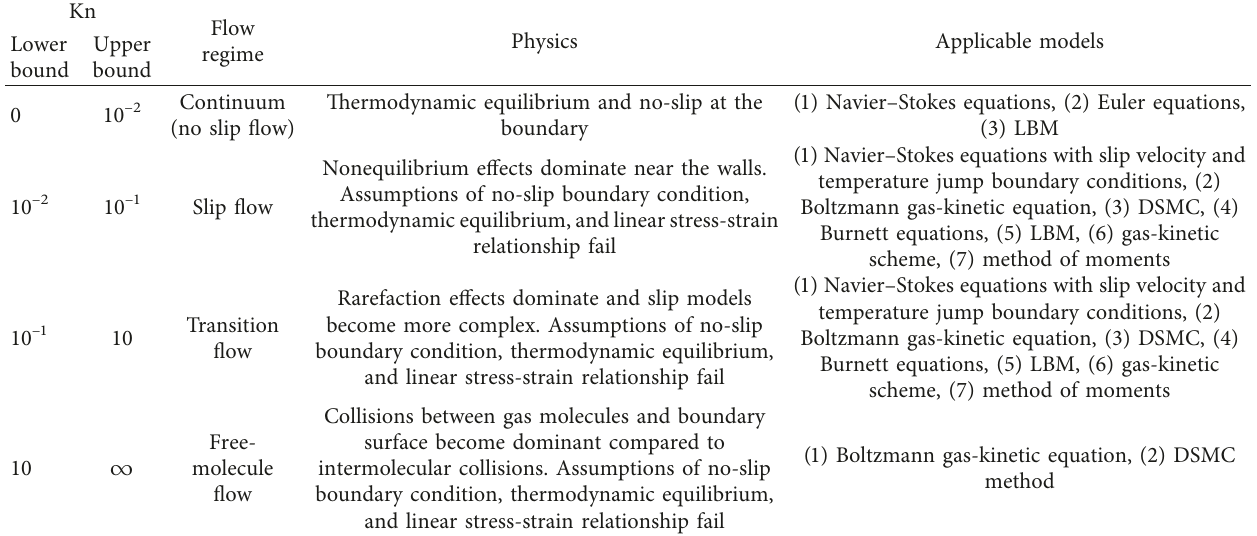
Table 1: Different flow regimes as a function of Knudsen